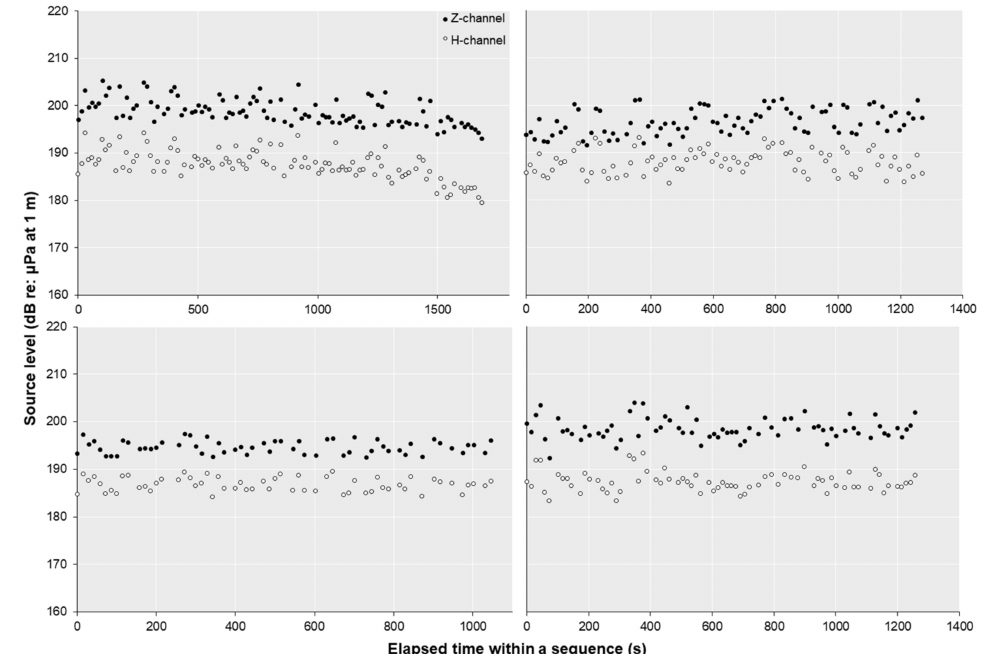
Figure 7. Examples of estimated source levels over elapsed time within sequences recorded on 11 January 2008 ( two top ), 26 December 2007 ( bottom-left ), and 1 February 2008 ( bottom-right ) in the southwest Portugal.